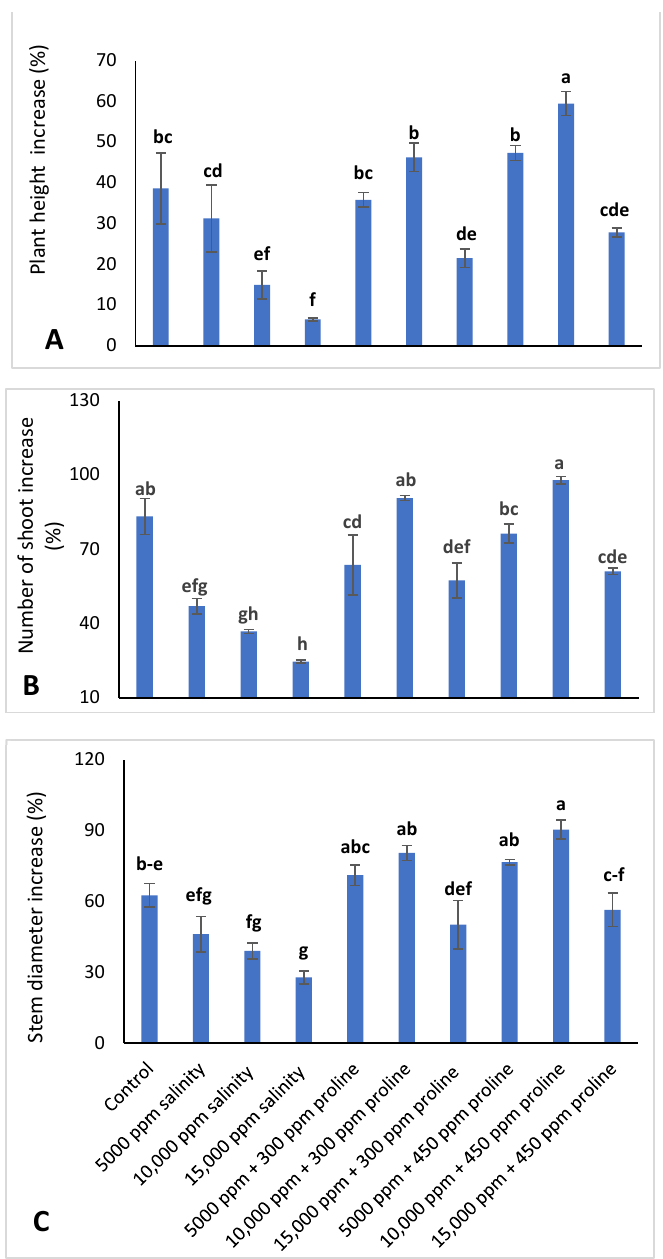
Figure 2. The effect of different levels of seawater salinity and exogenous proline at three concen- trations, 0 ppm, 300 ppm, and 450 ppm on plant height increase percentage ( A ), number of shoot increase percentage ( B ), and stem diameter increase percentage ( C ). Data are means of two seasons (2020 and 2021) and three replicates ( n = 3) for each season. The mean values ± SE of each parameter followed by different alphabetical letters are significantly different according to Duncan’s multiple range test at p ≤ 0.05.